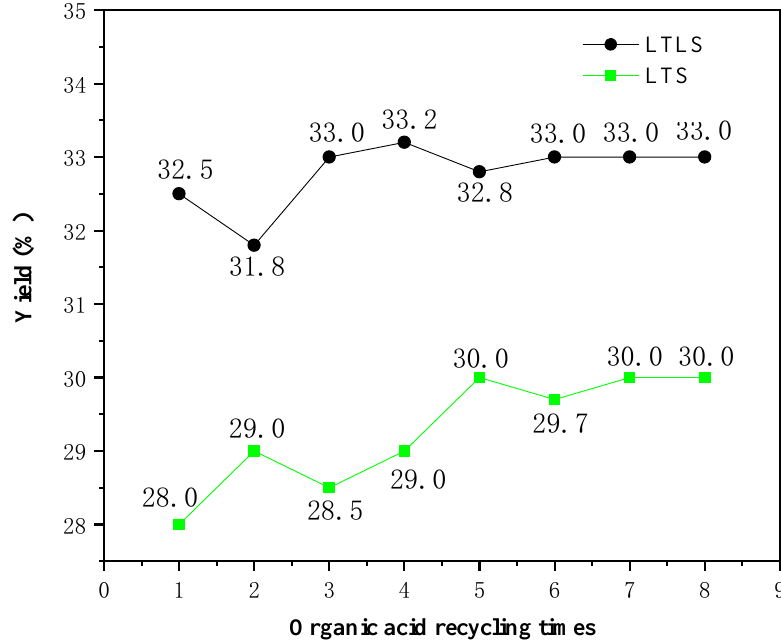
ff ects of circulating organic acids on the yield of the LTS and Figure 4. Effects of circulating organic acids on the yield of the LTS and LTLS. Figure 4. E